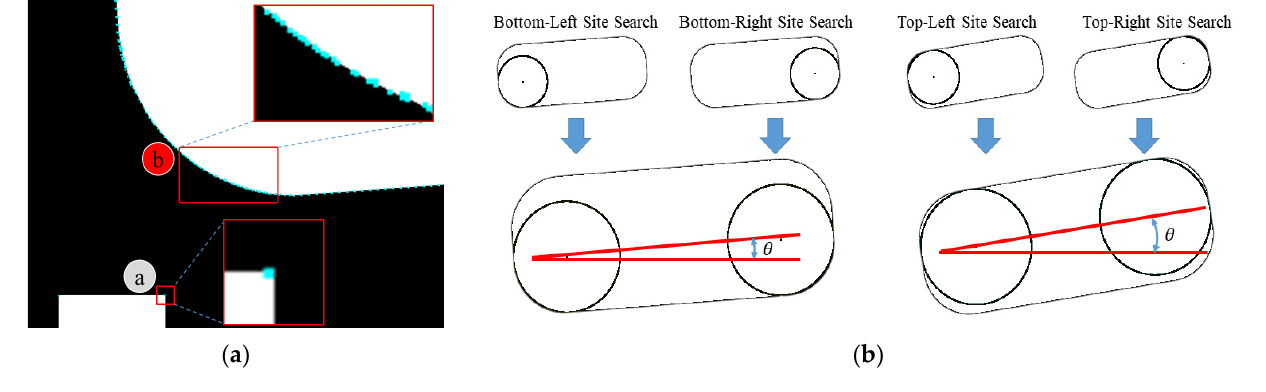
Figure 21. Experimental image sample and preprocessed image for the experiment. ( a ) Results of the Harris and Moravec Corner methods ( ⓐ : corner A, ⓑ : round corner B). ( b ) Slope calculation in the proposed method).